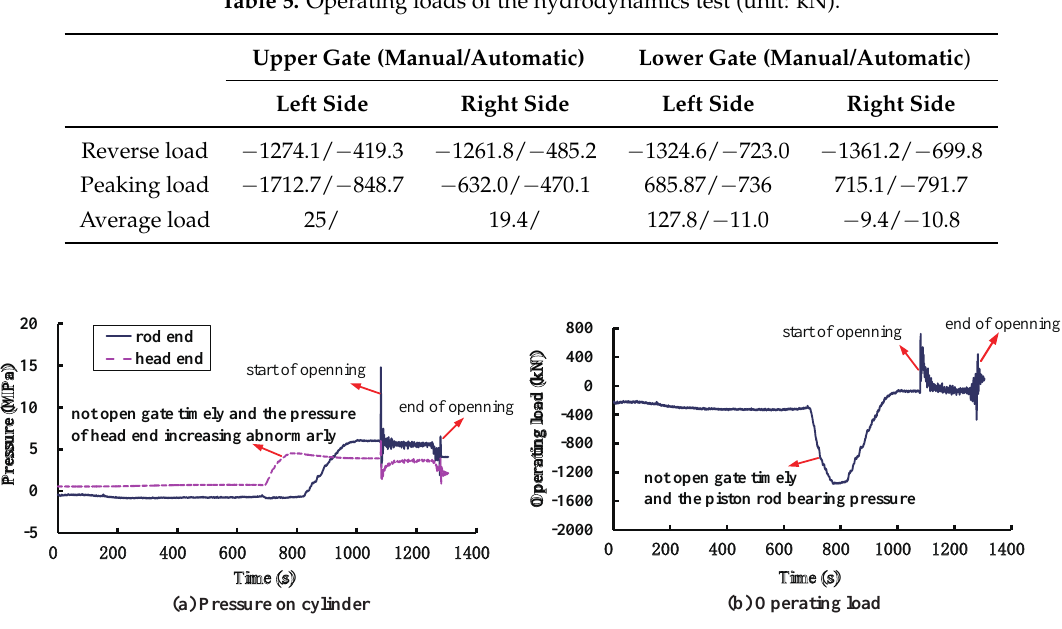
Figure 5. The pressure and operating load in the condition of manual